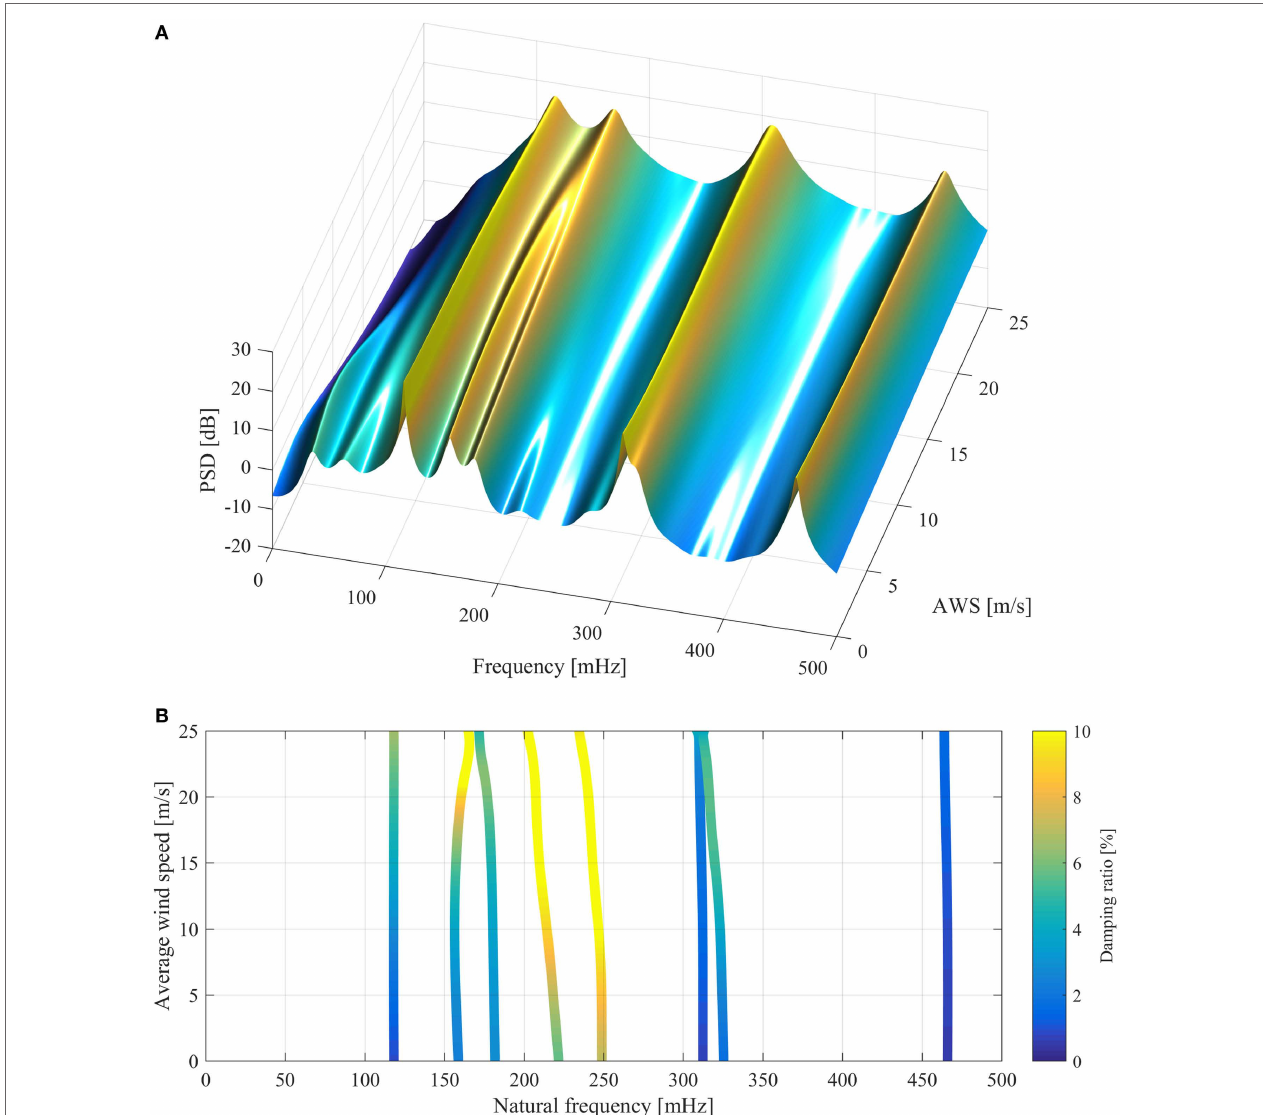
FIGURE 6 | GP-AR(72) p =4 model-based PSD, natural frequencies, and damping ratios as a function of the average wind speed in the range 0–25m/s. Frequency range and damping ratio limited to [0,500]mHz and [0,10]%, respectively. (A) PSD of the bridge vibration as a function of AWS; (B) natural frequencies and damping ratios as a function of